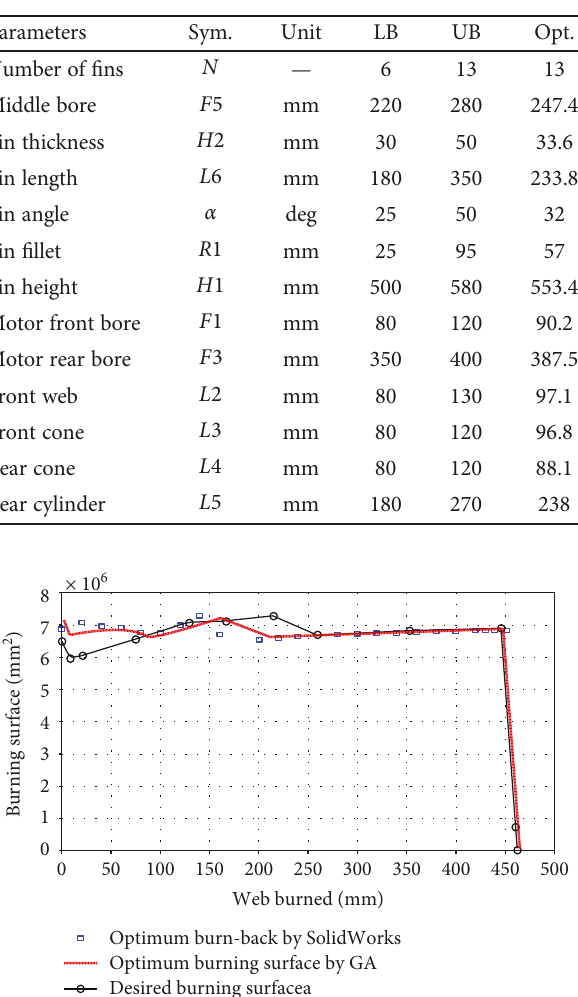
Table 3: Design variable of Finocyl grain limitation and optimum values after optimization.